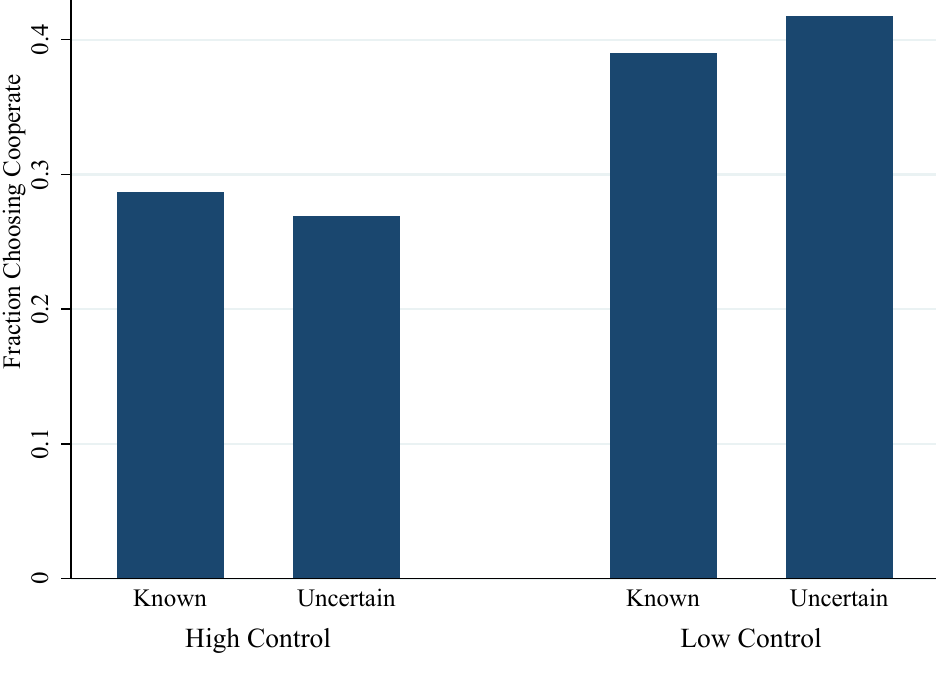
Figure 8. Average First Mover Cooperation by Treatment (First 10